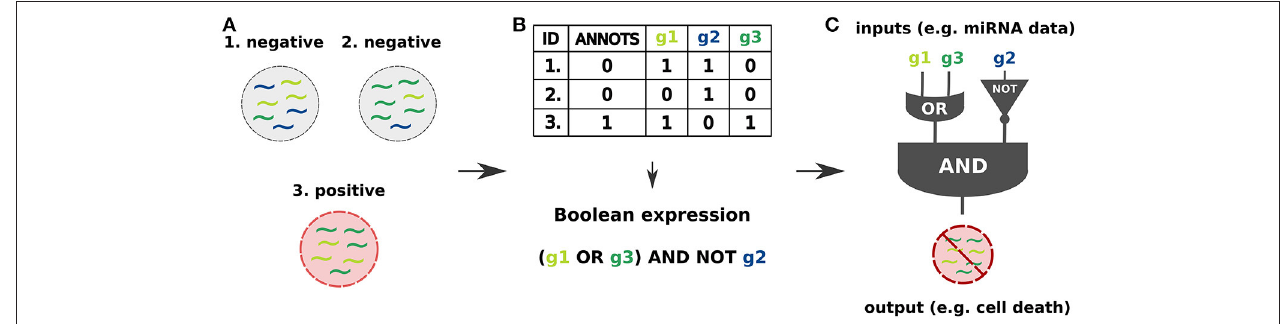
FIGURE 1 | Cell classifier circuits are synthetic logic circuits capable of sensing endogenous molecular signals (inputs) in a living cell, classifying them as type-specific signals and triggering a desired response (output) based on the classification result (Xie et al., 2011; Mohammadi et al., 2017). (A) The inputs may be specified as miRNA expression profiles identifying the cell state as healthy or diseased. (B) Binarization of continuous miRNA levels, characterizing them as high or low, allows to combine them into logic gates and define a Boolean function which allows to classify the cell state. (C) The input signals are processed by a synthetic regulatory network capable of triggering the response, which may be a controlled production of a desired RNA or protein output leading to a cell apoptosis.